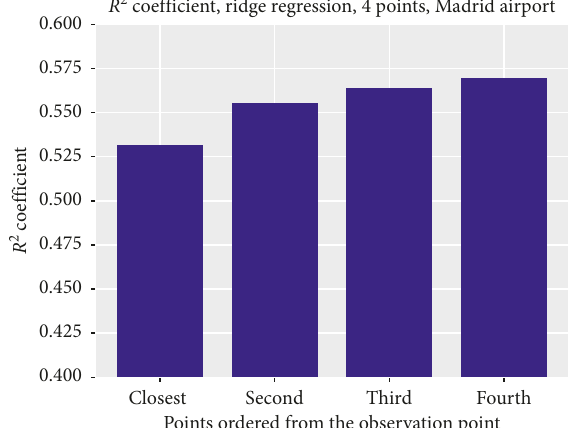
Figure 9: Quality of the ridge regression for the 4 closest points (wind speed).